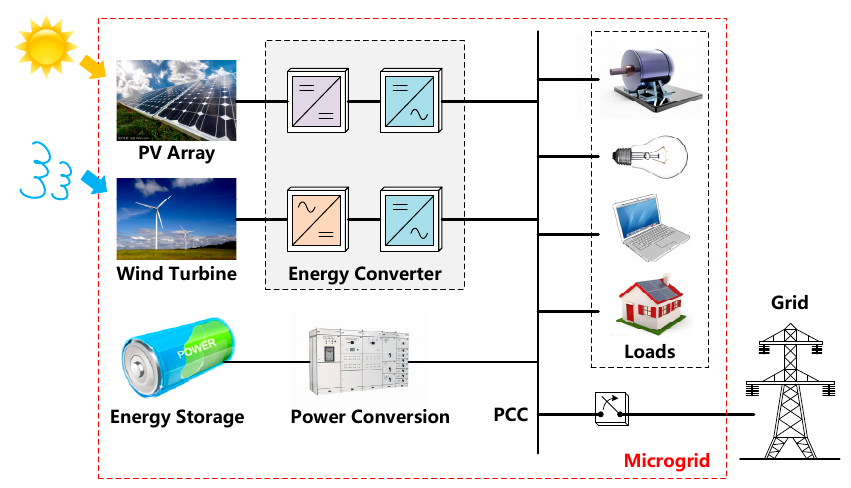
Figure 1. Diagram of the micro-grid.